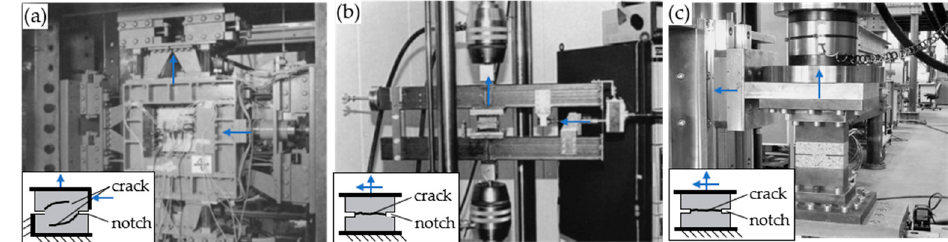
Figure 2. Mixed mode test setups by ( a ) Nooru-Mohamed [20] (1992), ( b ) Hassanzadeh [19] (1992), and ( c ) Jacobsen [21] (2012).